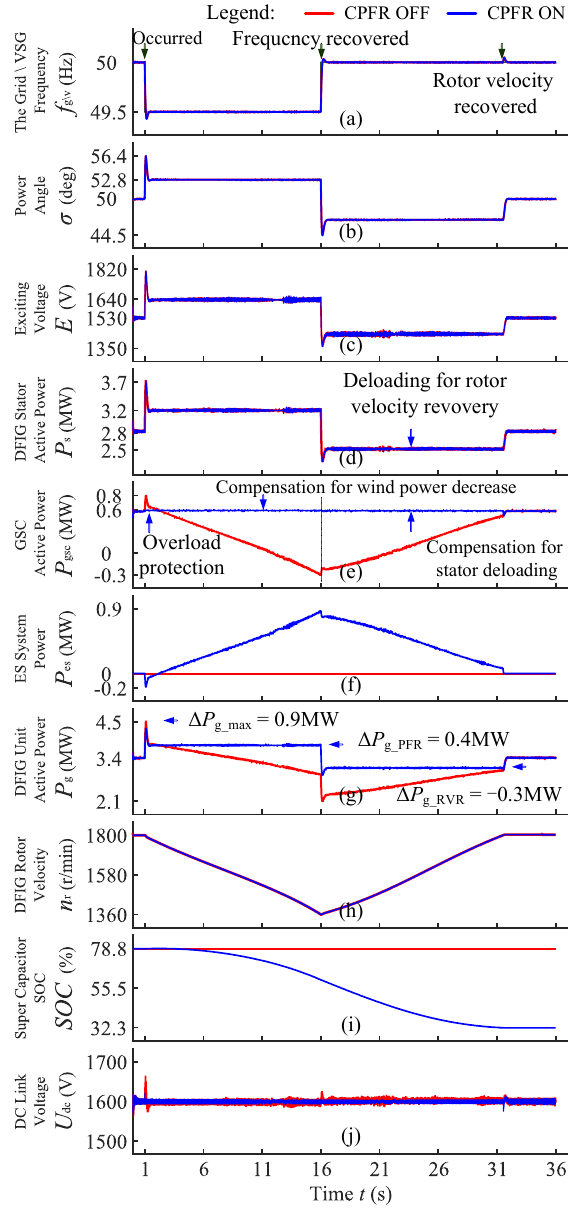
Figure 12. Frequency regulation operation waveforms of a DFIG-VSG at the rated wind speed: ( a – c ) The frequency, power angle and exciting voltage of the DFIG-VSG; ( d – g ) The stator power, GSC power, ESS power and generator unit power; ( h ) The rotor velocity; ( i ) SOC of the super capacitor; ( j ) DC link voltage.